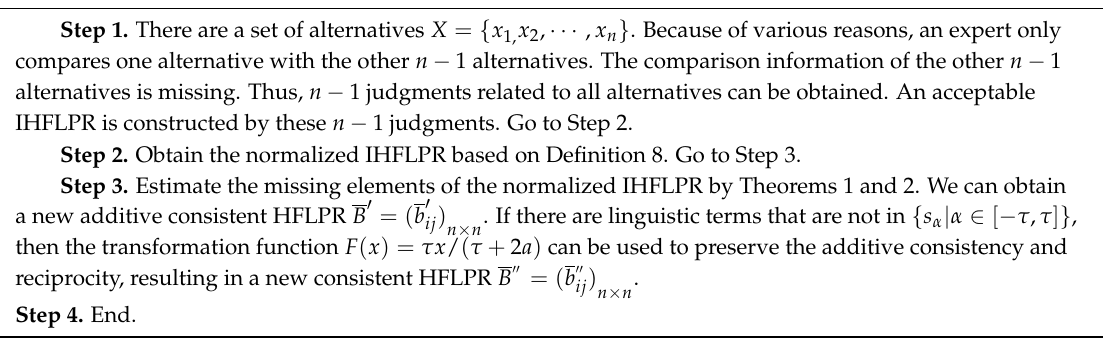
Algorithm 1. Estimating missing information of IHFLPR with n − 1 known